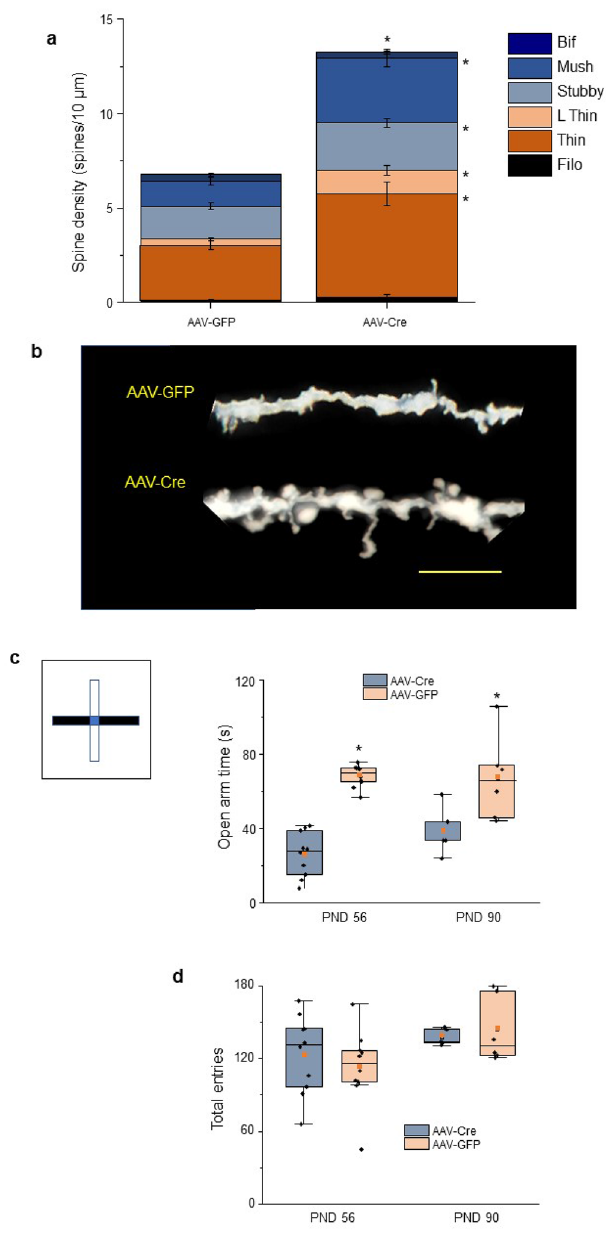
Figure 6. Local α4 knockdown at puberty increases spine density of L5 PL pyramidal cells at PND 56 and increases the anxiety response to an aversive stimulus. ( a ) Averaged data, spine density (#spines/10 μm) in post-pubertal (PND 56) female L5 PL following local α4 knockdown with AAV-Cre (right) compared to the AAV-GFP control (left). Total spines, t(16) = 4.94, *P = 0.0001; mushroom, t(16) = 3.89, *P = 0.0013; stubby, t(16) = 2.38, *P = 0.03; thin, t(16) = 3.63, *P = 0.0023; long thin, t(16) = 3.13, *P = 0.0065. ( b ) Representative images of basal dendrites from Golgi-stained neurons from the indicated groups. Scale, 5 μm. n = 36 neurons, 9 mice/group. ( c ) Inset, schematic drawing of elevated plus maze (EPM; arms, 30 cm long, 5 cm wide, elevated 40 cm): white, open arms, half enclosed by walls 7 cm high, extending 15 cm from the center; black, closed arms enclosed by walls 15.25 cm high for the entire length of the arm. ( c ) Mean (red square), median line, 25–75% interquartile range (IQR), SEM, and individual data points for open arm time in the EPM for PND 56 or PND 90 female mice injected with AAV-GFP or AAV-Cre in the PL on PND 21. PND 56, t(18) = 9.97, *P < 0.00001; PND 90, t(9) = 2.45, *P = 0.0366. A decrease in open arm time is an increase in avoidance behavior which reflects anxiety. ( d ) Mean (red square), median line, 25–75% interquartile range (IQR), SEM, and individual data points for total crossings in the EPM, measuring locomotor activity. n = 10 mice/group (PND 56); n = 5–6 mice/group (PND